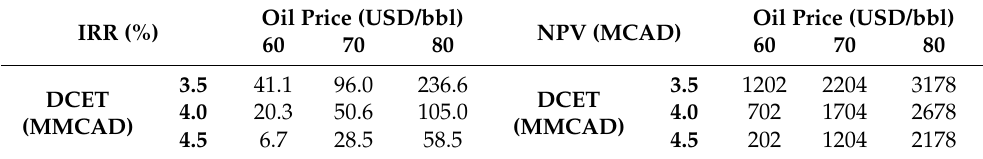
Table 4. Viking Economics Sensitivity Analysis with respect to oil price and DCET